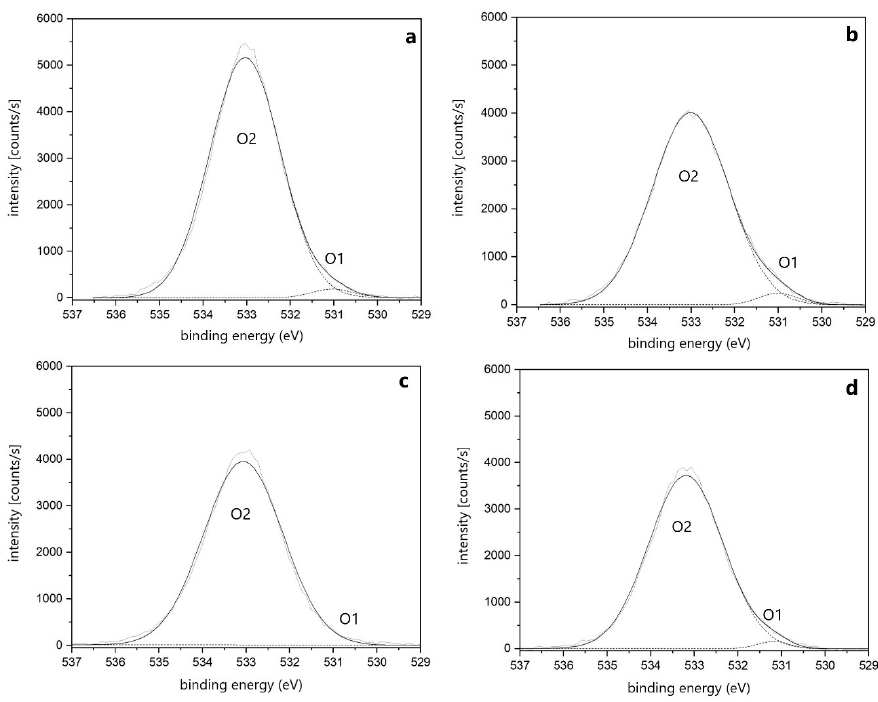
Figure 2. High-resolution spectra of the O1s energy level of ( a ) fresh elm, ( b ) archaeological elm, ( c ) fresh poplar, and ( d ) archaeological poplar.